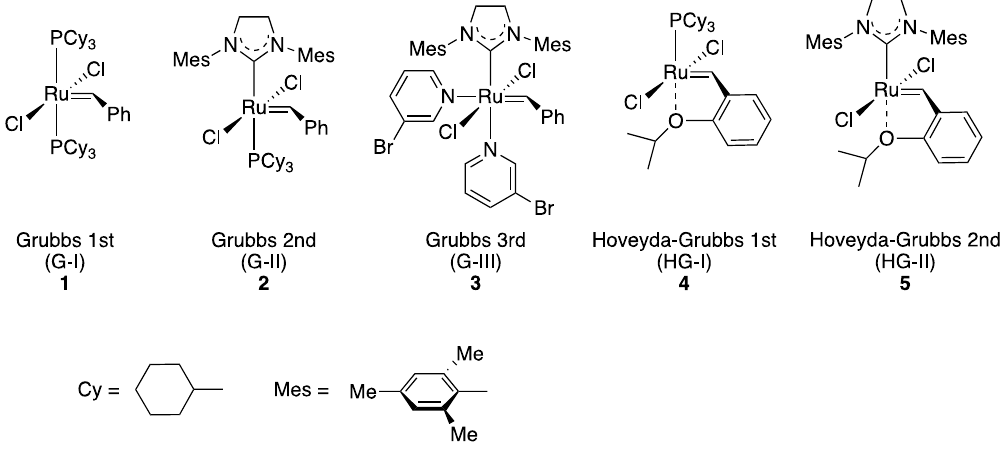
Figure 1. Grubbs catalyst and its derivatives 1 – 5 .